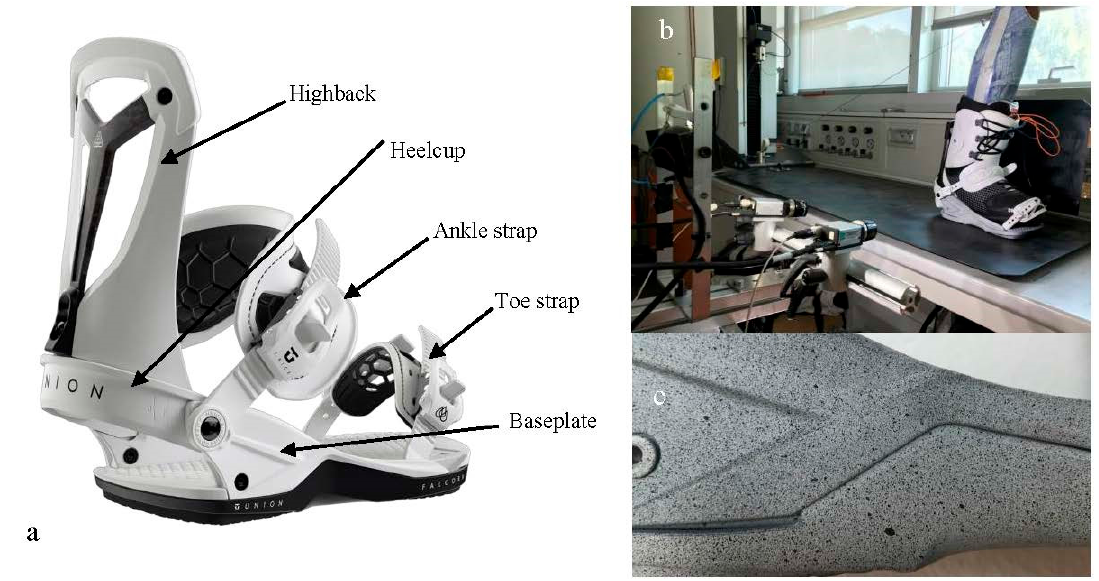
Figure 1. Falcor snowboard binding ( a ), flexural test bench used and digital image correlation (DIC) equipment ( b ) and stochastic pattern used to perform DIC analysis ( c